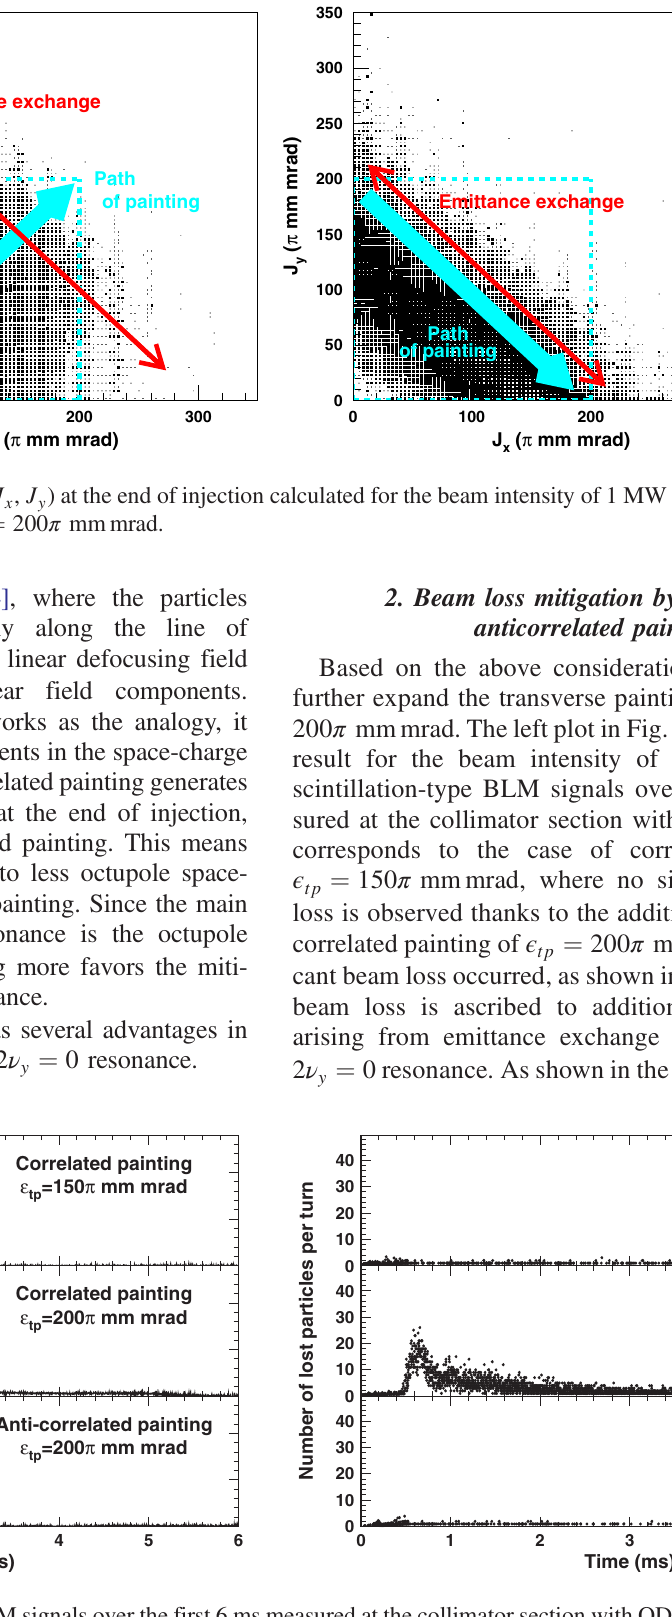
FIG. 37. (Left) Scintillation-type BLM signals over the first 6 ms measured at the collimator section with QDTs for the beam intensity of 1 MW; (top) correlated painting of ϵ tp ¼ 150 π mm mrad, (middle) correlated painting of ϵ tp ¼ 200 π mm mrad, and (bottom) anticorrelated painting of ϵ tp ¼ 200 π mm mrad. (Right) Corresponding numerical simulation